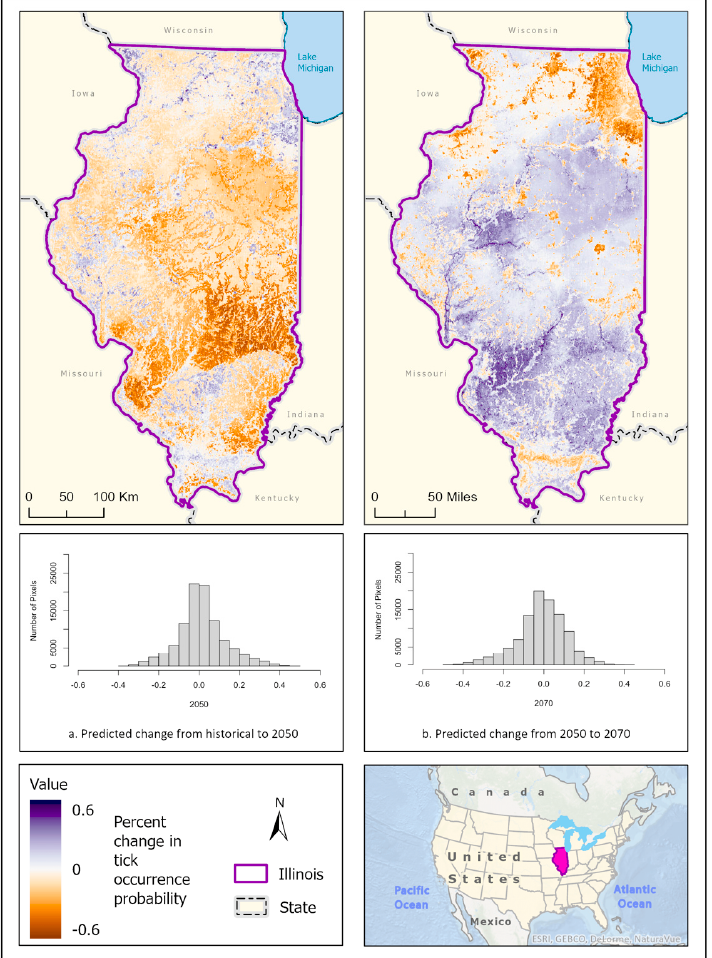
Figure 5. Percent change in the likelihood of A. americanum occurrence between the historical climate and 2050 ( left ) and from 2050 to 2070 ( right ). Red shades indicate a reduced likelihood of occurrence (negative change), and blue shades indicate an increased likelihood of occurrence (positive change). The histograms represent the number of pixels (y − axis) containing the binned percentage likelihood change (x − axis) of A. americanum suitable habitat across the map. Inset map indicates the location of Illinois within the United States/North America.